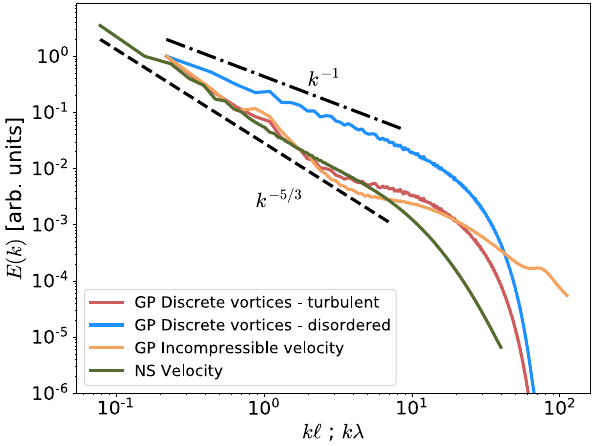
Fig. 2 Kinetic energy spectrum in quantum and classical turbulence. Spectra are obtained from simulations of the generalised Gross – Pitaevskii (GP) model and the incompressible Navier – Stokes (NS) equations. Wave numbers k are, respectively, normalised by the mean inter-vortex distance ℓ and by the Taylor micro-scale λ , while the vertical axis is in arbitrary units. In the GP case, the incompressible part of the kinetic energy is plotted 63 . Also shown are the energy spectra obtained after applying the vortex detection procedure to the GP fi elds (see “ Methods ” for details), both before and after the randomisation of the vortex orientations (turbulent and disordered cases, respectively). Dashed and dash-dotted lines, respectively, represent the Kolmogorov scaling k − 5/3 and the disordered scaling k − 1 . Source data are provided as a Source Data fi